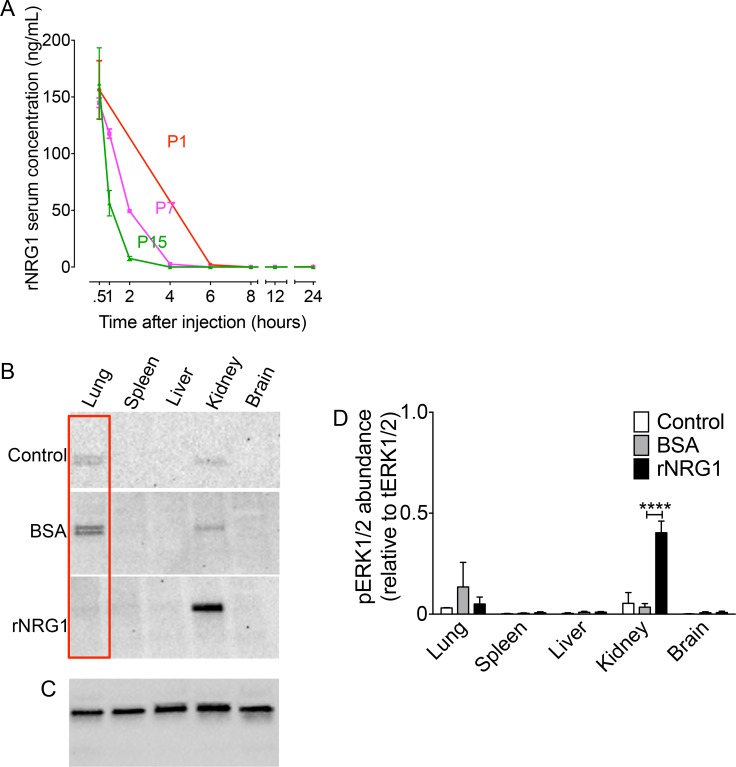
A single weight-adjusted rNRG1-injection in neonatal mice induces similar peak rNRG1 concentrations in serum and significant increases in phospho ERK1/2 in kidney.Mice of indicated ages received one subcutaneous injection of rNRG1 (0.1 μg/g). (A) The serum concentration of rNRG1 was determined by ELISA. (B-D) Mice either received no injection (control) or one BSA or rNRG1 injection on day of life 7 (P7) and organs were resected 1.5 hours later. Western blots showed phospho-ERK1/2 (B), and total ERK1/2 levels (C) in organs analyzed. Red rectangles indicate an example of corresponding control and treatment groups (B). Total ERK1/2 loading control is a representative example of all treatment groups (C). Quantification of phospho-ERK1/2 abundance normalized to their respective total ERK1/2 loading controls (D). Statistical analysis was tested with ANOVA followed by Bonferroni’s multiple comparison test (D). ****P<0.0001. Error bars indicate SEM. n = 2 for P1, n = 3 for P7, and P15 (A); n = 3 (B-D).